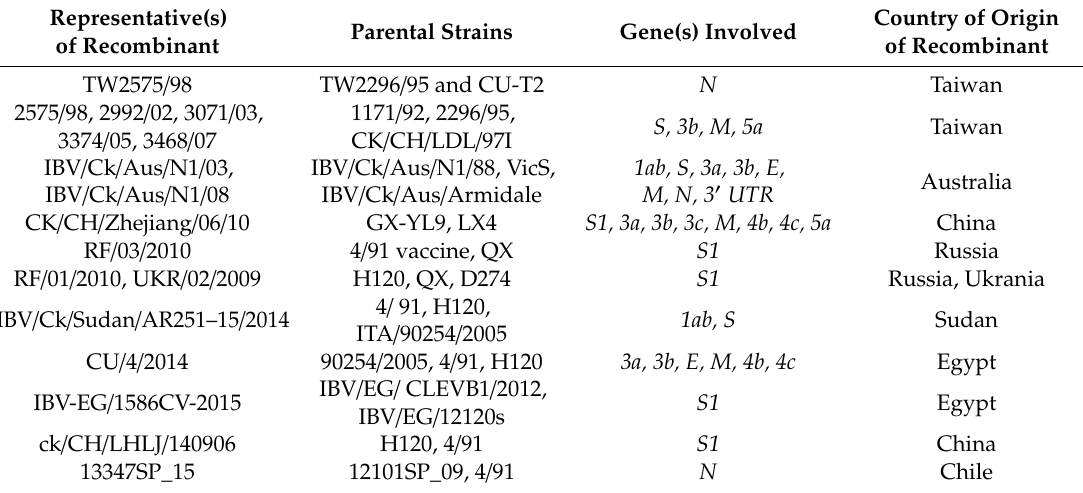
Table 2. Evidence of recombination in strains isolated from di ff erent